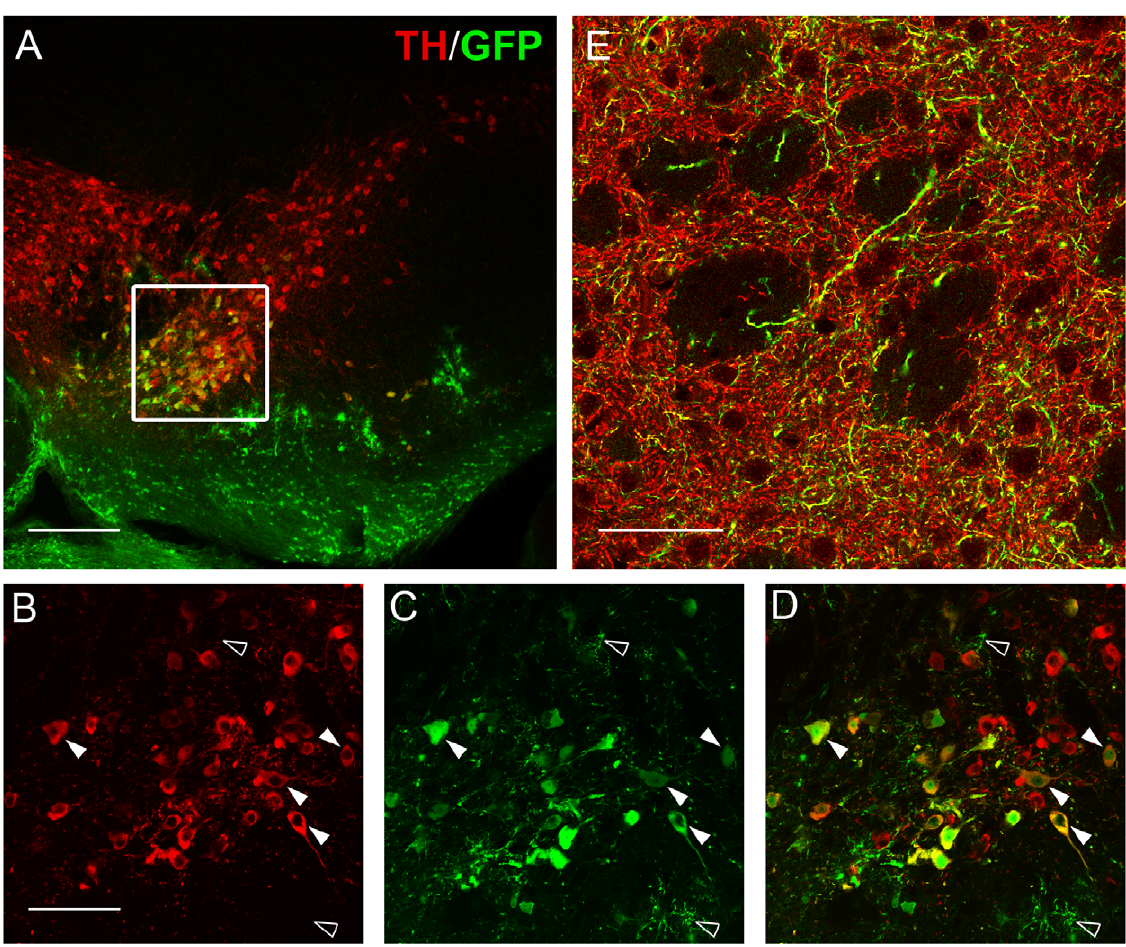
Figure 3. hCAR transgenic animals exhibit transduction of dopamine neurons by Ad5 vectors. Delivery of Ad5 to the SN in the hCAR mouse shows a broadened transduction profile including TH + neurons by confocal microscopy. Transgene expression extends into the STR terminal fields. ( A ) Low power image of the hCAR SN shows a broadened transduction profile of Ad that includes TH-positive neurons, in addition to astrocytes. Magnification of the region outlined in A shows many TH-positive cells (red, B ) staining positive for GFP (green, C ) overlaid in D (see closed arrowheads). GFP-positive cells with astrocyte morphology can also be seen in this region (open arrowheads). ( E ) Visualization in the STR shows many fibers labeling with GFP, indicating their transduction by Ad5 delivered in the SNc. Red = TH-positive neurons, Green = GFP, Yellow = double positive. Scale bar A : 500 m m, B–D : 100 m m, E : 50 m m.